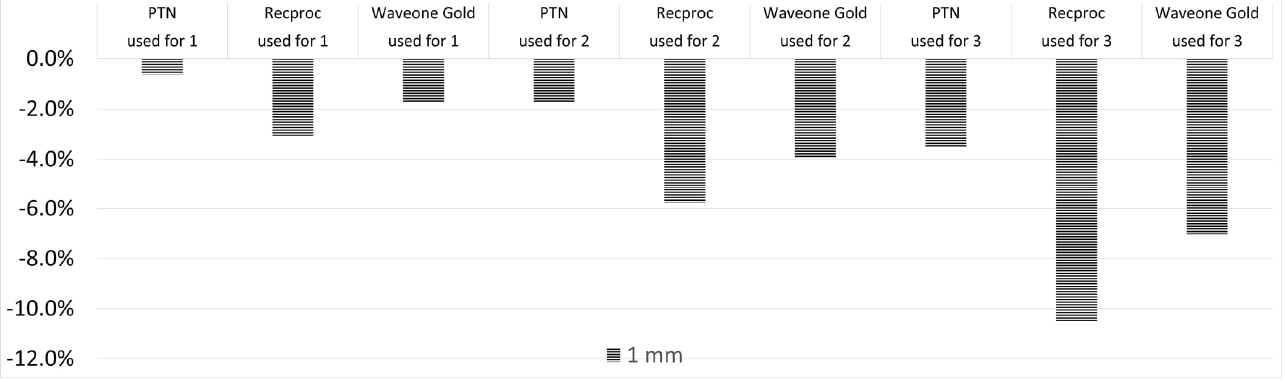
Figure 2. Comparison of the average wear values of the files were measured at 1st millimeter from the apical compared to the file that was never used between different file systems.